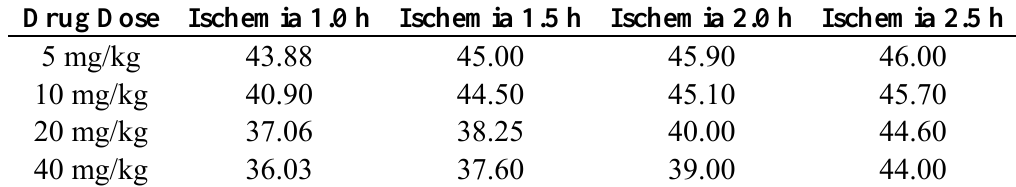
Table 6. The expression positive cells of S-100.